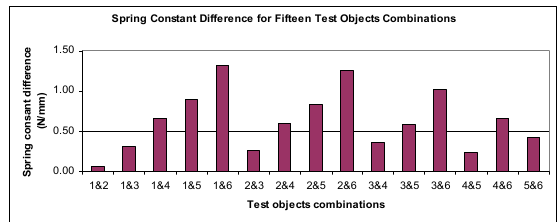
Fig. 6. Spring constant difference of the fifteen test object